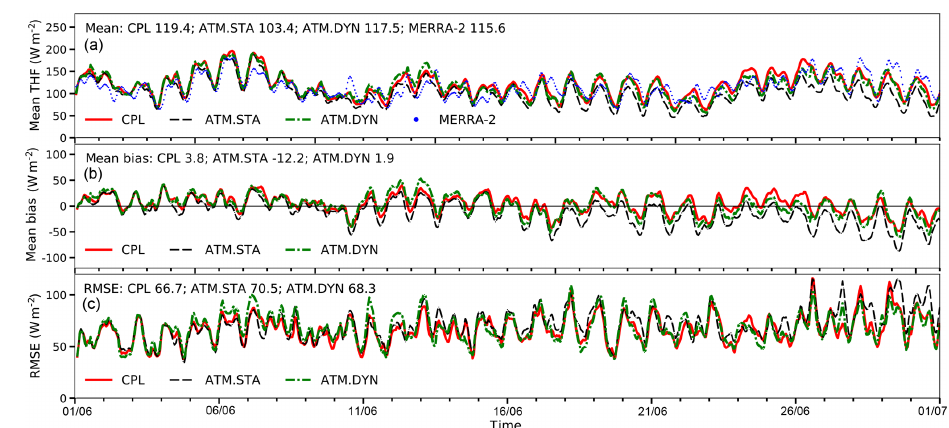
Figure 10. The turbulent heat fluxes out of the sea obtained in CPL, ATM.STA, and ATM.DYN in comparison with MERRA-2. Panel (a) shows the mean THF; (b) shows the mean bias; (c) shows the RMSE. Only the hourly heat fluxes over the sea are shown.